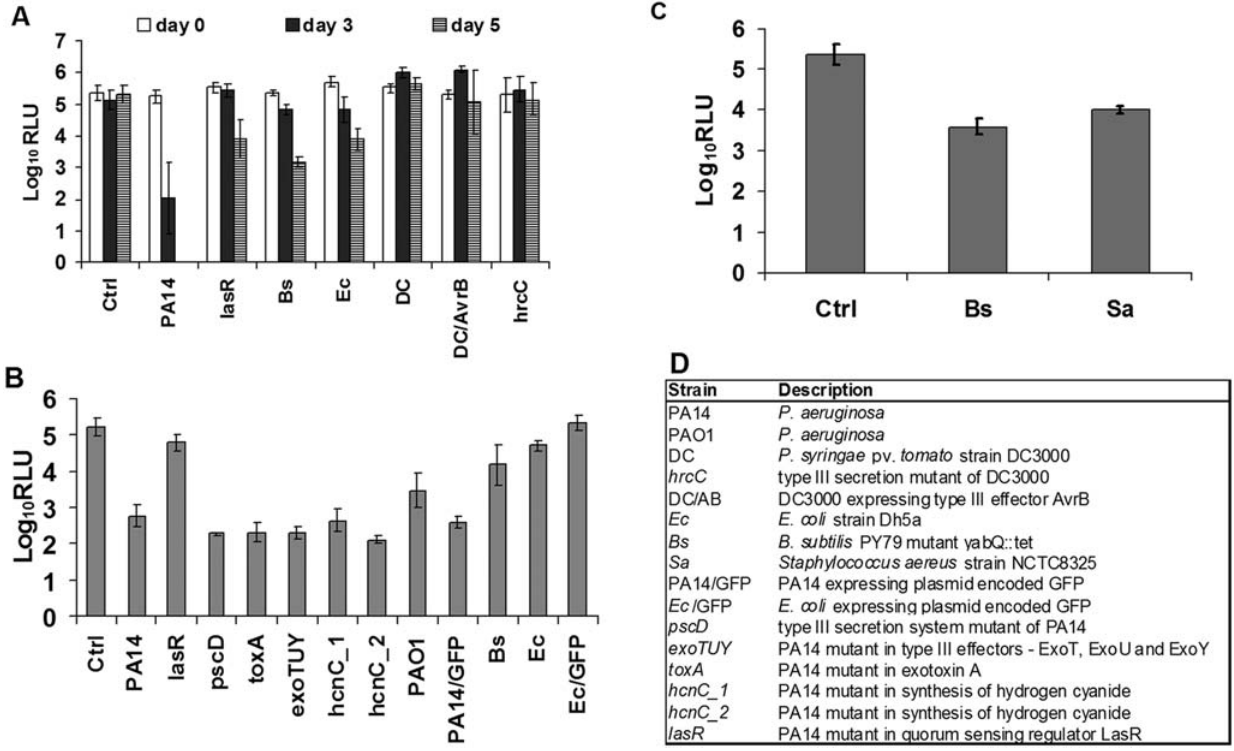
Figure 2. Activity of seedlings engineered to constitutively expressed luciferase after infection with different microbes. ( A ) The seedlings were infected with microbes as in Fig. 1 and the luciferase activity were measured on the same seedlings before and after addition of microbes (Panel D ) at indicated time points. ( B ) Seedlings were infected with different microbes or different mutants of P. aeruginosa strain PA14 (Panel D ) and luciferase activity measured 2 dpi. ( C ) Seedlings were infected with B. subtilis or S. aureus and luciferase activity measured 3 dpi. Ctrl is control uninfected seedlings. Shown are log 10 relative luminescence units. ( D ) List of strains used in the luciferase assays.